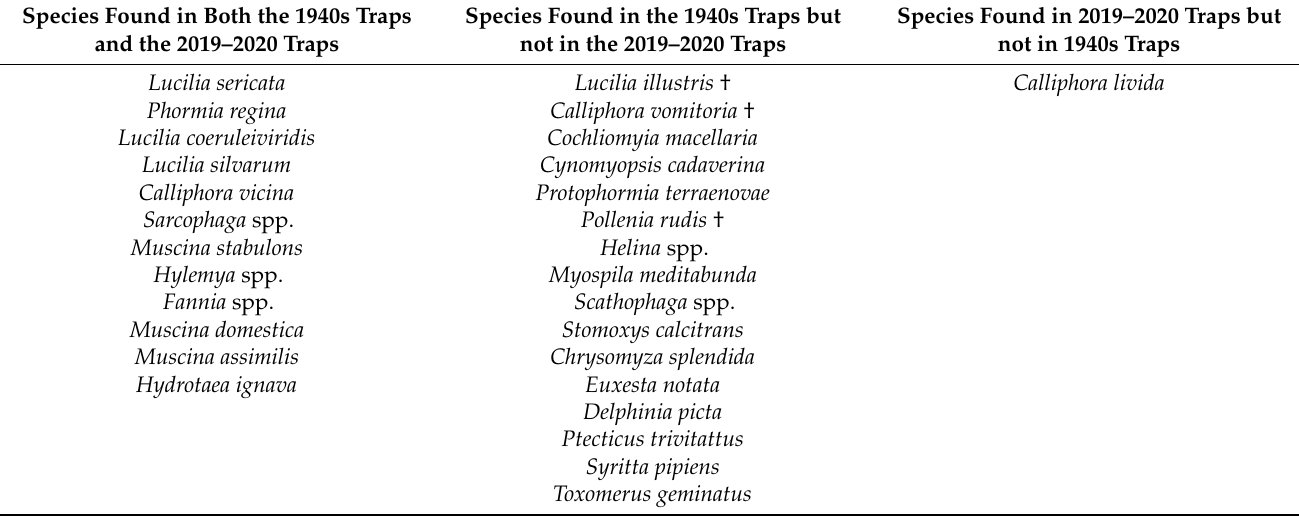
Table 4. Differences in fly species trapped in the current and 1940s surveys. Species Found in Both the 1940s Traps Species Found in the 1940s Traps but